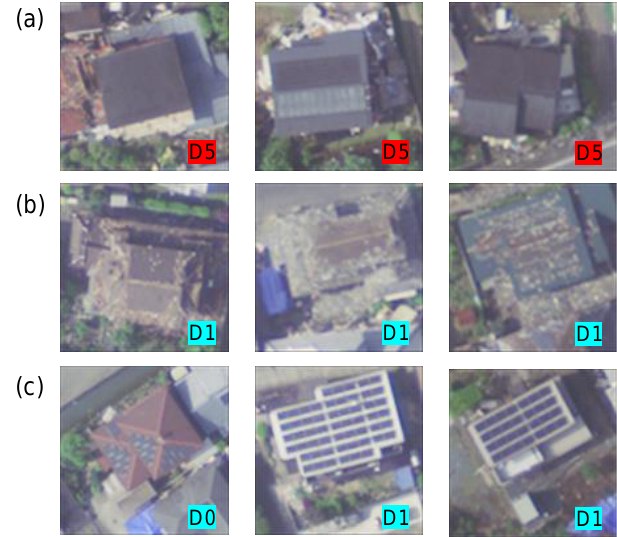
Figure 11. Close-ups of the images falsely classified by the CNN model. ( a ) Soft-story collapsed buildings (D5). ( b ) D1 buildings with seriously damaged roofs. ( c ) D0–D1 buildings with solar panels on the roofs.